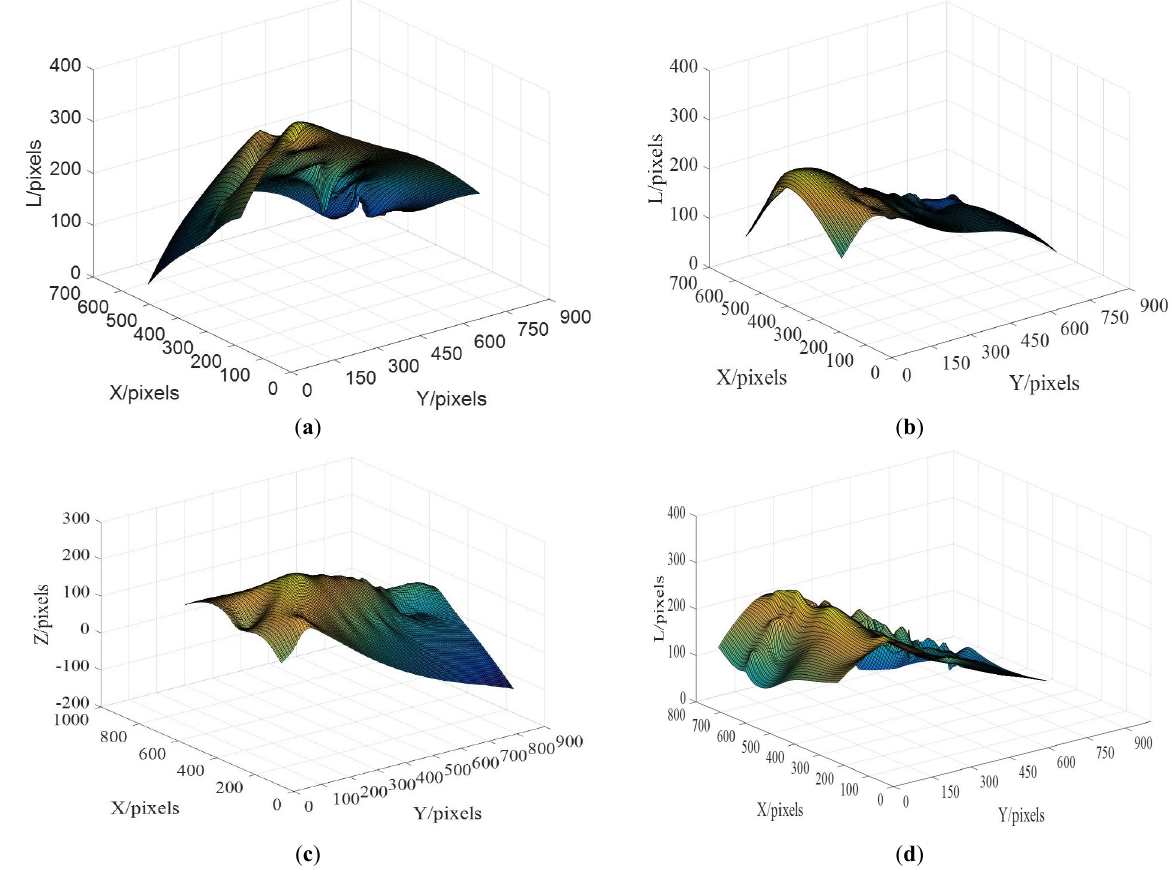
Figure 9. The size-position model of the four typical ship images: ( a ) cargo ship; ( b ) passenger ship; ( c ) sand ship; ( d ) small ship.